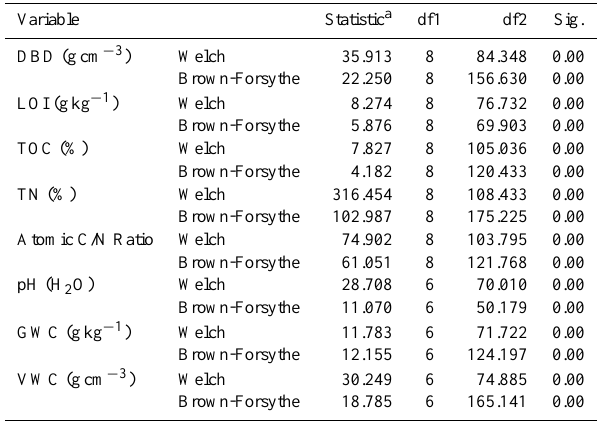
Logged over Peat Forest (LF)